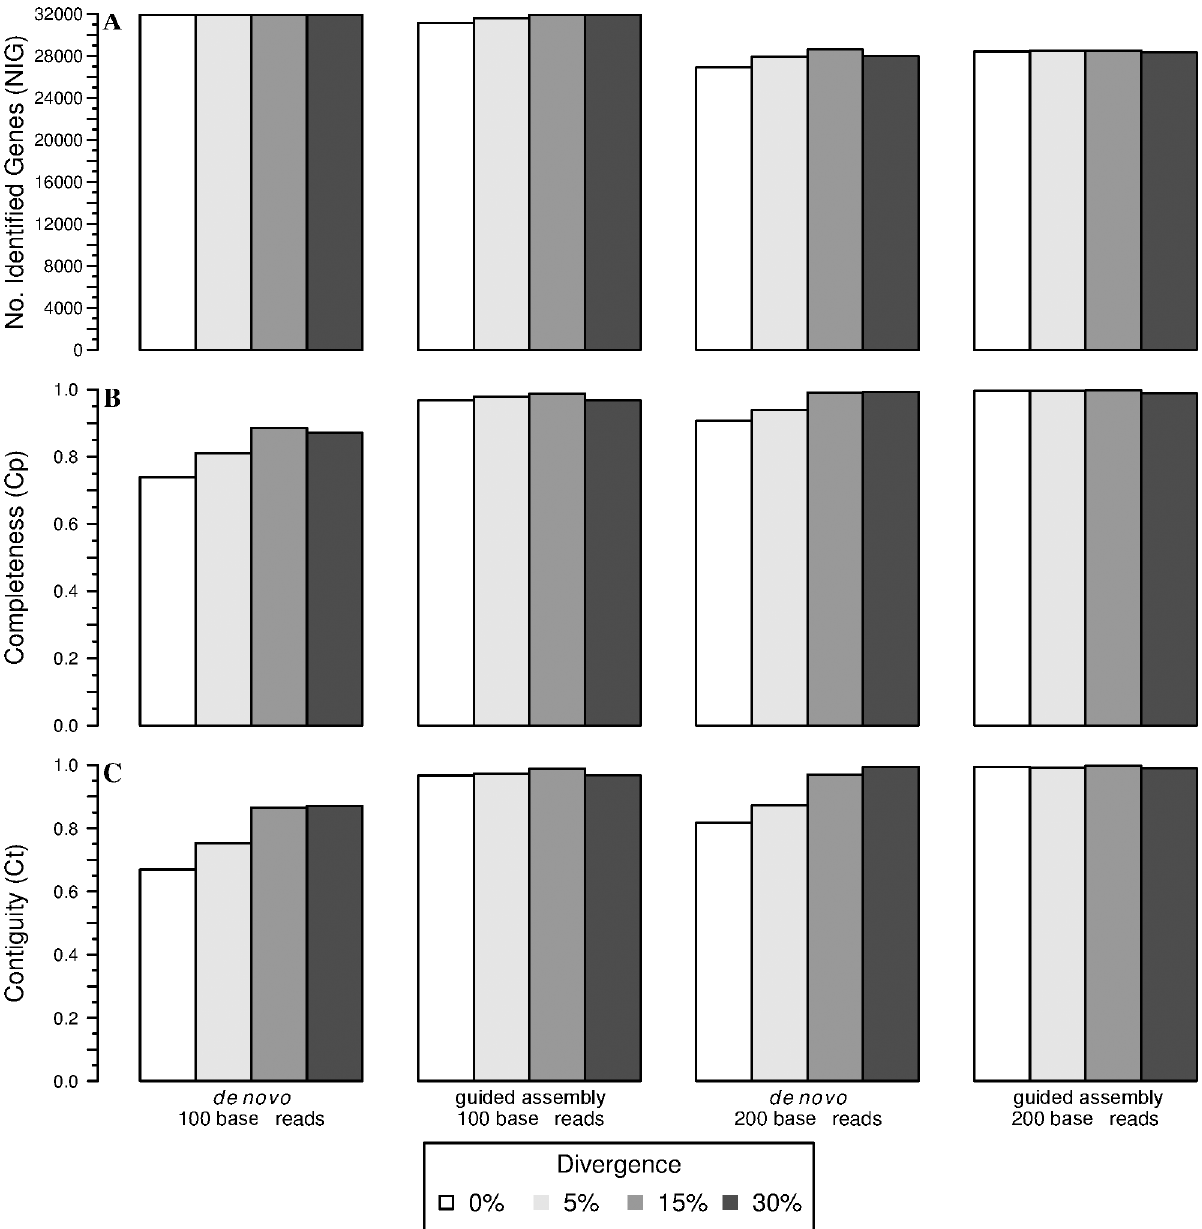
Fig 4. Efficiency and performance of de novo and transcriptome-guided assembly based on Blastn by read length and divergence level. (A) Number of identifiedgenes; (B) completeness; (C) contiguity. Divergencebetweentarget and reference transcriptomes is describedin the figure